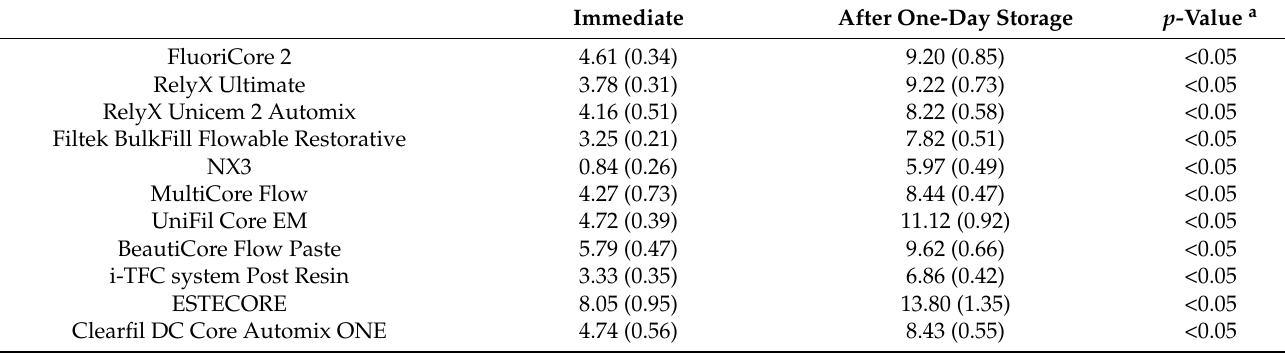
Table 9. Flexural modulus of various core build-up materials and luting materials (GPa, mean (S.D.)).